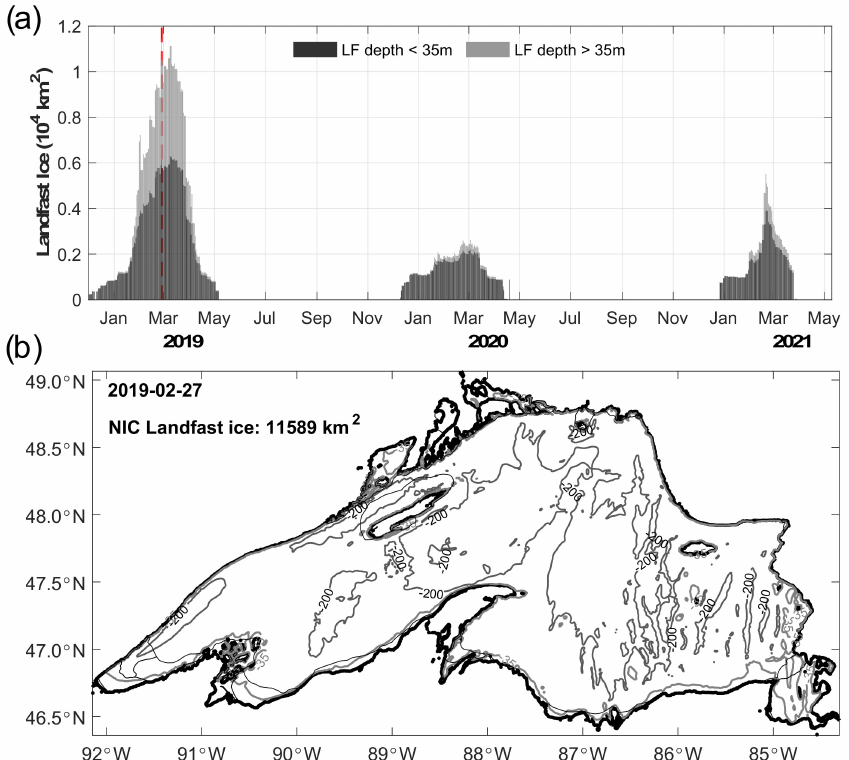
Figure 2. ( a ) Bar chart of landfast ice area (km 2 ) from the National Ice Center (NIC) between December 2018 to May 2021. Black indicates water depth less than 35 m and gray indicates greater than 35 m. The red vertical dashed line indicates the date of 27 February 2019 for ( b ). ( b ) A snapshot of landfast ice (color regions) from NIC on 27 February 2019. The first and the second gray contours indicate the 35 m and the 200 m isobath,